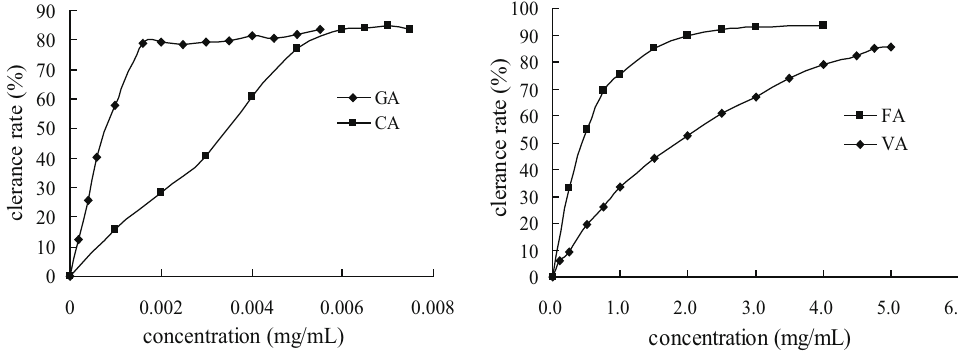
Figure 9: DPPH free radical scavenging of polyphenols studied in this